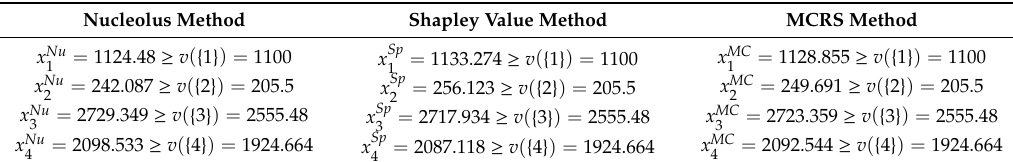
Table 3. Individual rationality analysis (MWh).